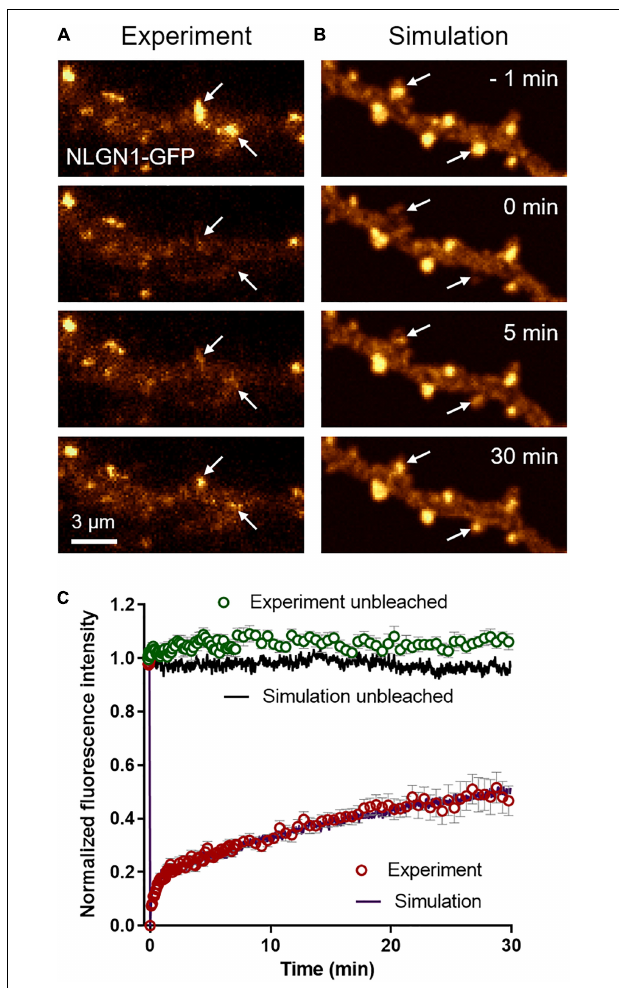
FIGURE 3 | Long term turnover of NLGN1 at synapses monitored by FRAP. (A) Representative time sequence of a FRAP experiment performed on a neuron expressing NLGN1-GFP. The GFP signal is color coded in gold to better visualize intensity changes over time. NLGN1-GFP was photobleached at time 0 with a focused 491-nm laser beam at two specific synapses where NLGN1 was accumulated (arrows), and fluorescence recovery was monitored for 30 min. (B) Corresponding simulated FRAP sequence. The dendritic geometry of 135 µ m 2 was filled with 25,000 individual molecules, each with a realistic point spread function, together providing a fluorescence-like image that is also color coded in gold. The fluorescence intensity of molecules inside two PSDs was decreased by 75% at time zero (arrows), mimicking the action of the laser. (C) Normalized FRAP curves obtained by experiment (open circles) in bleached synapses (red, mean ± SEM of 25 synapses from 4 neurons) or unbleached synapses (green, mean ± SEM of 11 synapses from 4 neurons) and corresponding simulations (solid curves, average of 10 repetitions each, SEM < 1% mean, not shown). The Spearman correlation coefficient between experimental and simulated data for bleached synapses was 0.98, while the parameter χ 2 estimating the goodness of fit was 0.05, both values being calculated out of 100 time